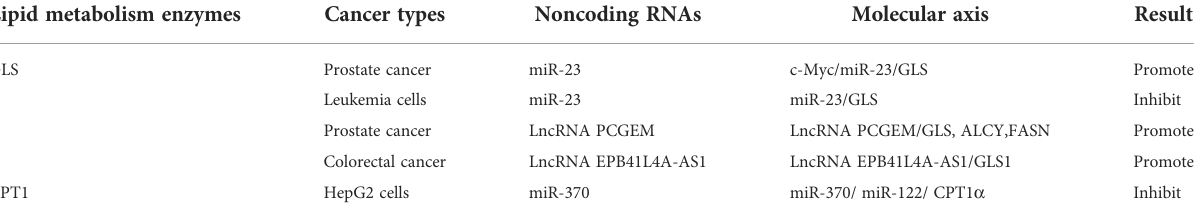
TABLE 3 Indirect signaling pathways of Noncoding RNAs in tumor lipid